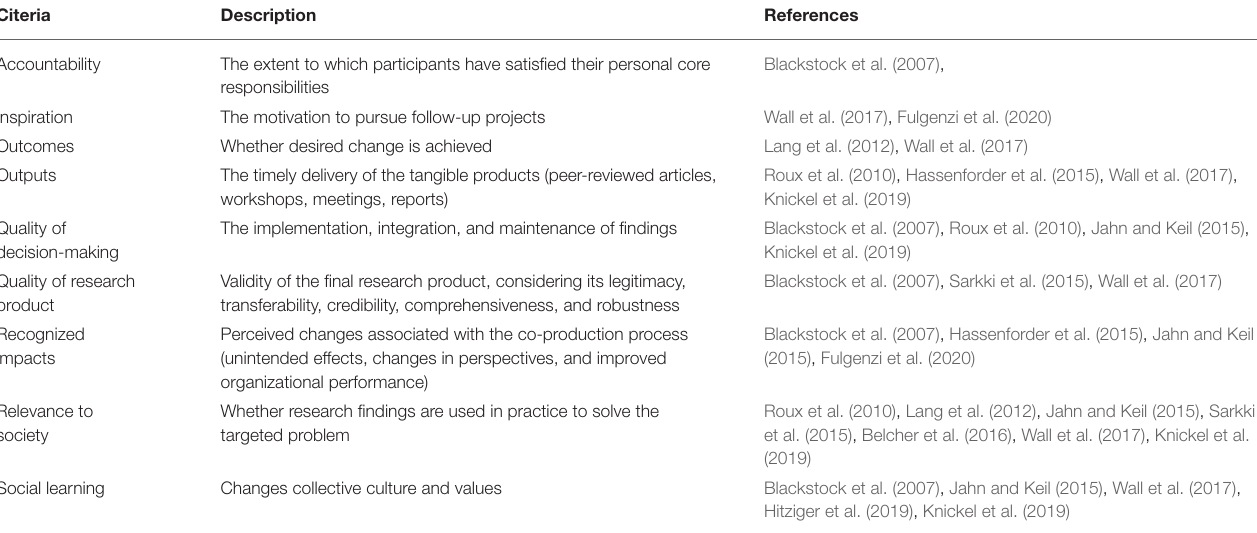
TABLE 4 | Criteria for evaluating co-produced knowledge – the effects.